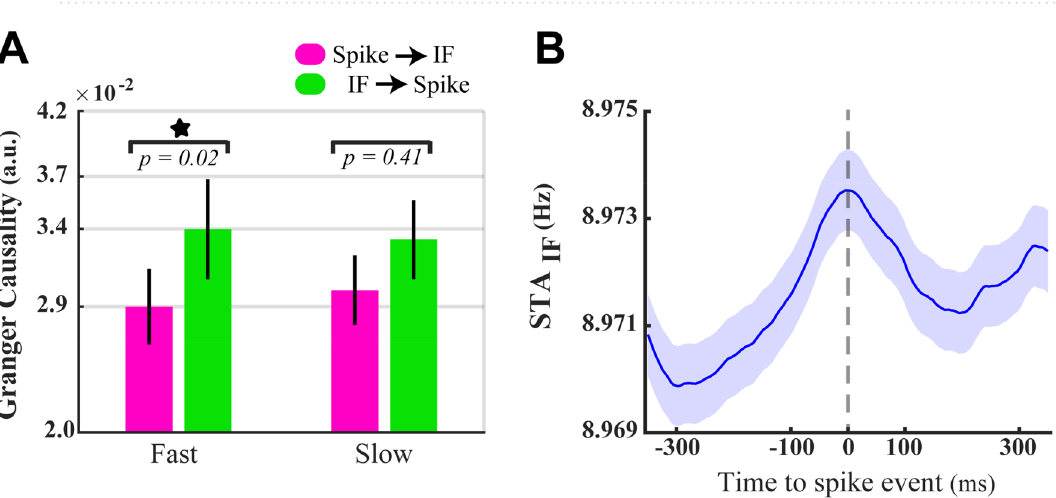
Figure 8. Granger causal influence between spike output and frequency of input oscillatory activity. ( A ) Directional effect of the theta–alpha IF on spiking activity of neurons (green color) and vice versa (purple color) among fast and slow RT trials. The Asterisk indicates a significant difference between two opposite causal influences in fast RT trials ( p < 0.03, Wilcoxon signed-rank test). The error bars show ± 1 STD. ( B ) Spike triggered averages of IF in the theta–alpha band. The mid-dashed line illustrates the time when neurons were discharging. The error bars represent the ±